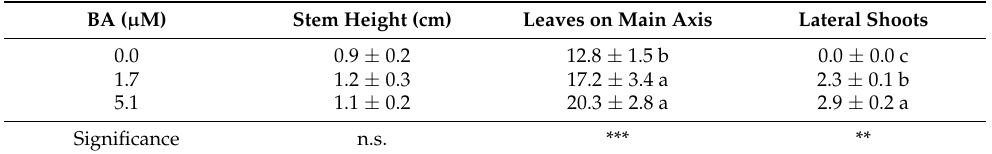
Figure 6. Effects of BA supply on GF677 microcuttings ( A , F , K ). Explants of the GF677 rootstock were grown on media without BA ( A – E ) or containing BA at concentrations of 1.7 ( F – J ) and 5.1 µM ( K – O ). Ten days post-treatment, the effects of BA dosage in increasing the numbers of side shoots and leaves (compare ( F , K ) vs. ( A )) were visible. ( B – E , G – J , L – O ) Histological analyses of longitudinal sections at early stages (3 days after treatment). Median section through the dome of control ( B ) and BA-treated apices ( G , L ). Leaf axillary buds showed a plethora of phenotypes, including normal ( C , D , H , M ), elongating ( I ), and swollen ( O ). Section of stems portions adjacent to medium ( E , J ). Bar sizes: 0.5 cm in ( A , F , K ); 150 µm in ( D , I , L – N ); 160 µm in ( B , G , H , J , L , O ); 170 µm in ( C ). Table 2. Phenotypical traits of GF677 rootstock microcuttings grown on media supplied with different BA dosages.